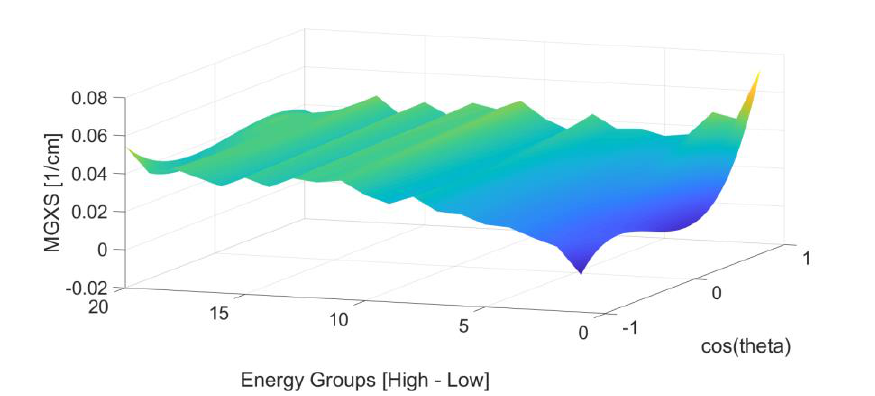
Figure 4. Scattering cross-section as a function of angle (up to P3) and energy (node located at the fuel